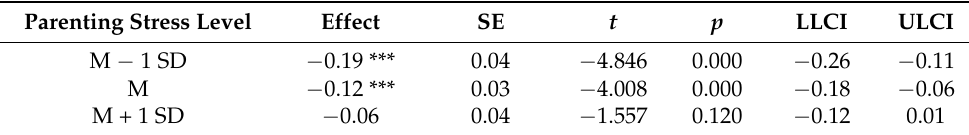
Figure 2. Interaction between mother–child attachment and parenting stress on children’s EBPs. Table 3. Moderation effect of maternal parenting stress. Parenting Stress